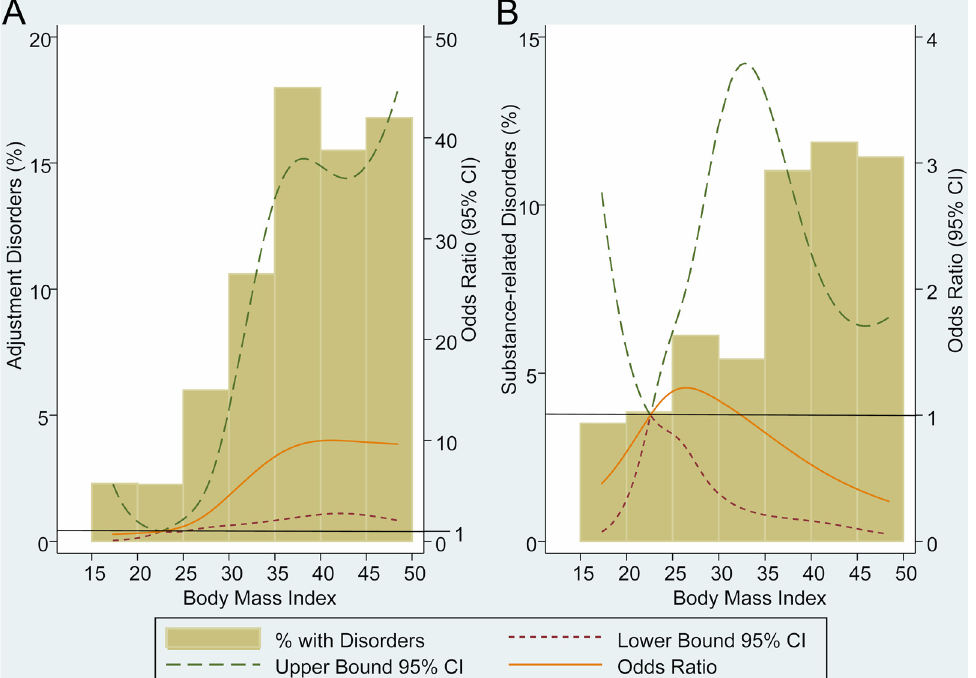
Fig 2. Odds ratio and percentage of adjustment and substance-related disorders across the continuum of BMI. (A) Adjusted by age, gender, origin, educational level, family history of psychiatric disease and eating disorders; (B) Adjusted by age, gender, live alone, paid work, origin, family history of obesity, family history of psychiatric disease, substance-related disorders, eating disorders and cluster C personality disorders; CI = confidence interval.